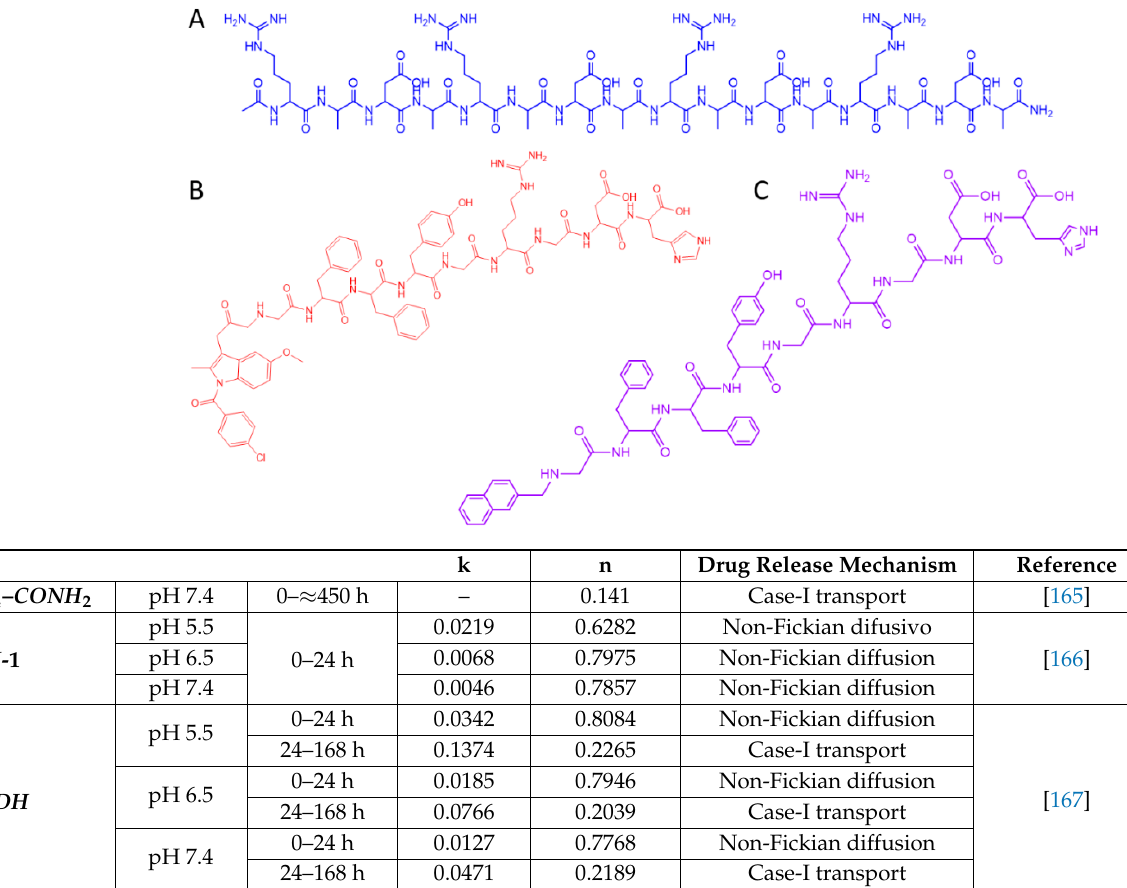
Table 1. Kinetic constants and diffusion exponents for ac–(RADA)4–CONH 2 , IDM-1 and 1-RGDH, according to the pH conditions tested in the corresponding experiments. (Data from [163–165]).